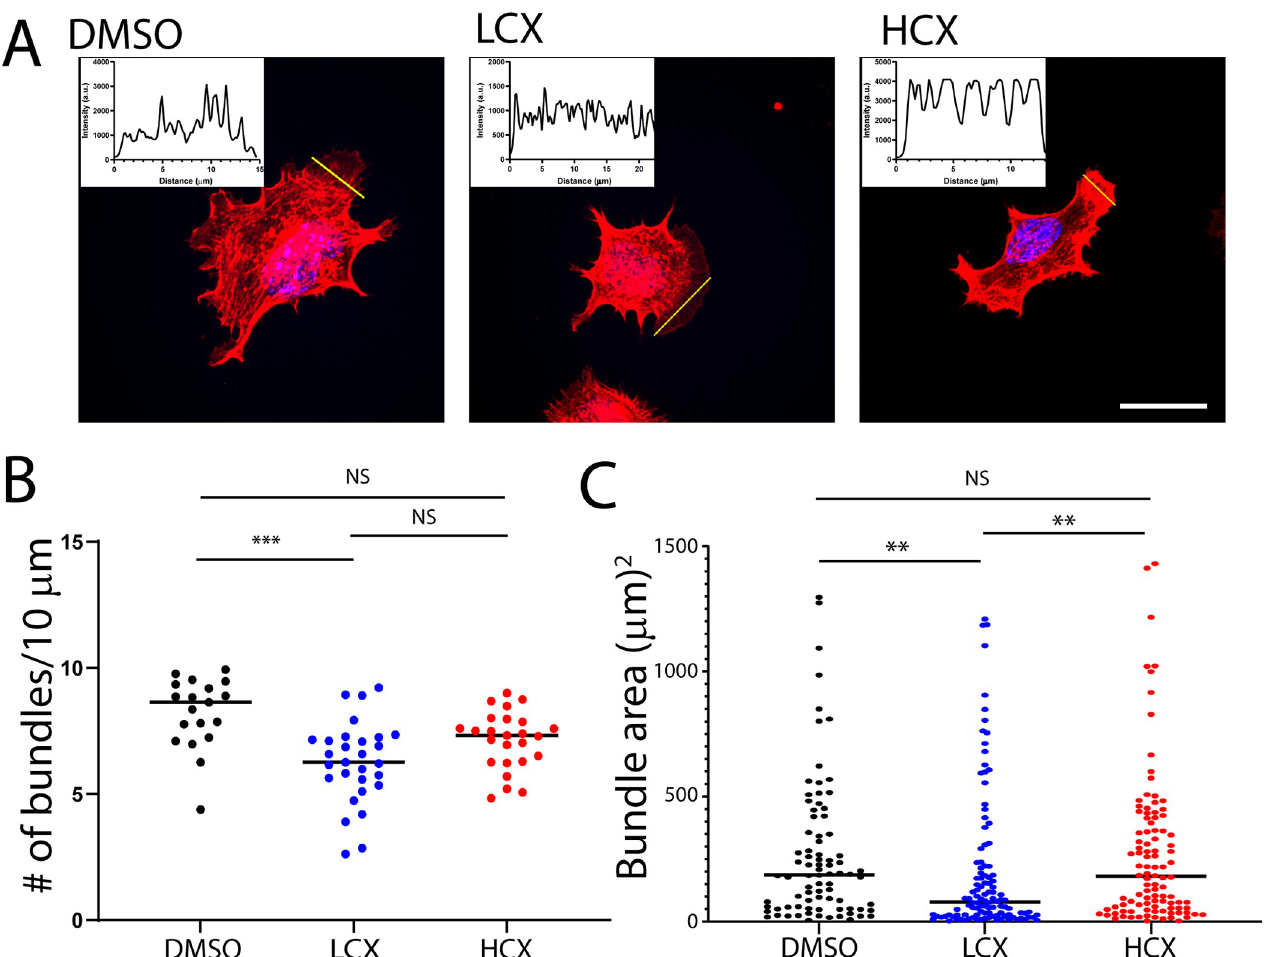
Fig 3. LCX alters actin bundling. A) Representative fluorescence images of living Neuro2a cells expressing F-tractin treated with DMSO, LCX, or HCX for 48 h. Insets show line scans of fluorescence intensity across the lamellipodia of indicated cells. B) Plots of area under the curve and the number of peaks for each of the three conditions. Scale = 25 μ m. �� p <